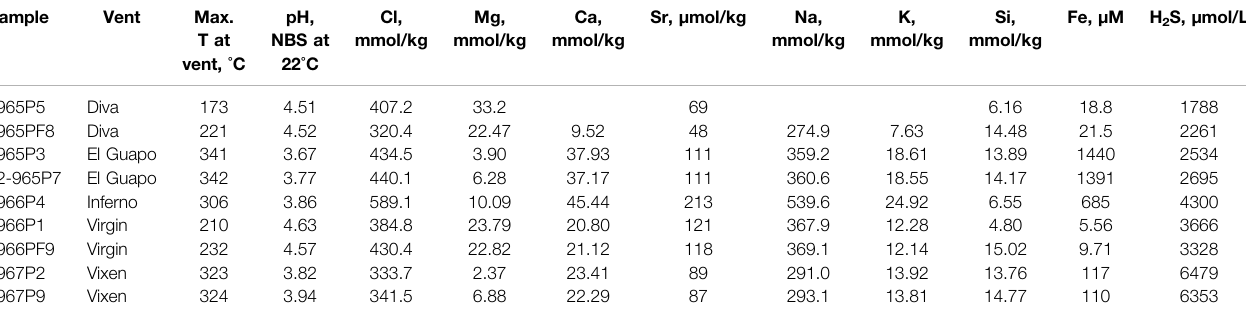
TABLE 1 | Measured concentrations of chemical species in high-temperature hydrothermal fl uids from the Axial Seamount.